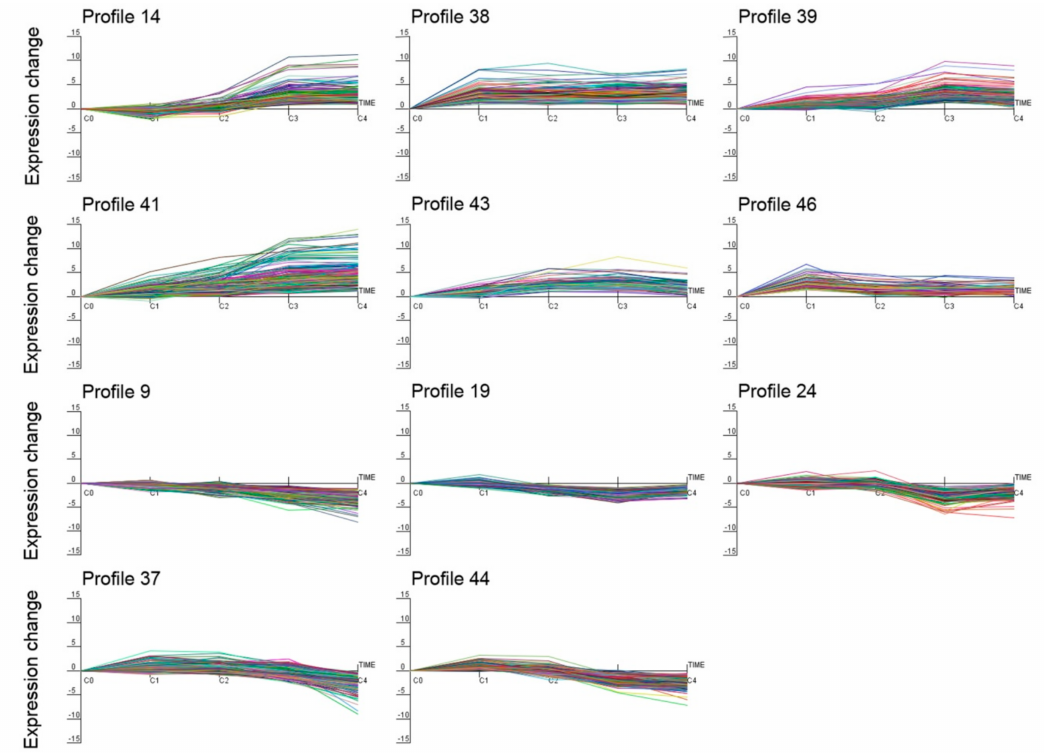
Figure 5. Differentially expressed gene expression profiles. The x-axis represents different cold processing points, and the y-axis represents the expression change. Profiles 14, 38, 39, 41, 43, and 46 are up-regulated patterns, and profiles 9, 19, 24, 37, and 44 are down-regulated